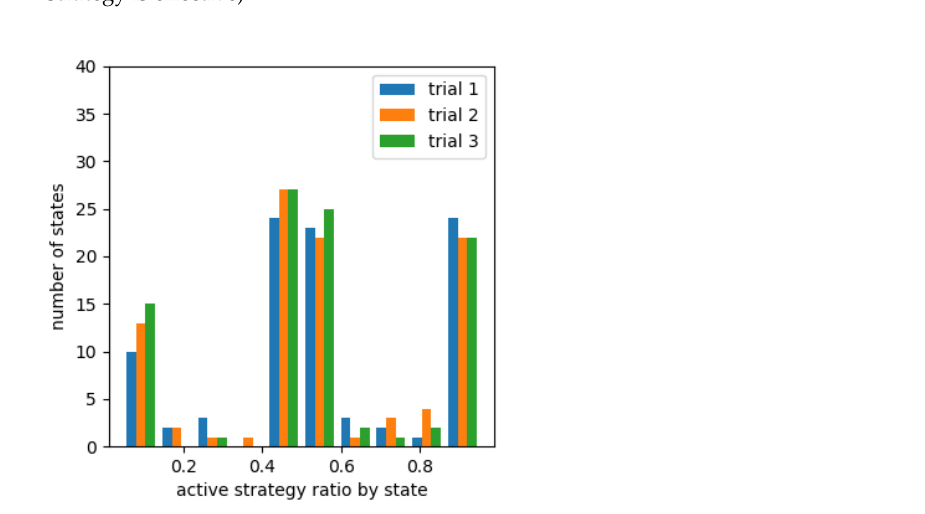
Figure 13. Percentage of active strategies chosen by state (cooperative rewards (20, 10), after active strategy is